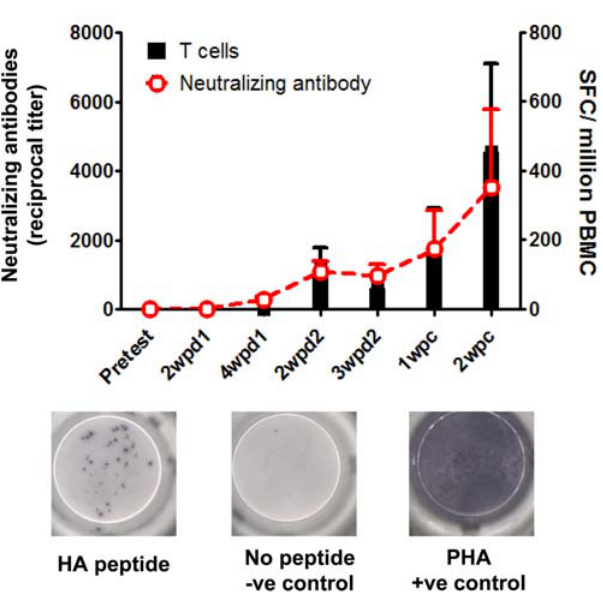
Figure 3. T cell responses against HA antigens in rhesus macaques and its relationship to the neutralizing antibody. T cell responses in the PBMC samples were measured by overlapping peptides and ex-vivo IFN- c ELISPOT assay. Data shown are the mean numbers 6 s.d. of spot-forming cells (SFC) per 10 6 PBMCs to HA peptide pools in the vaccinated animals at different time points after vaccination and challenge. Neutralizing antibody in the serum samples was measured by the microneutralization method using AH/05 virus isolate, data shown are mean titers 6 s.d. The T cell response and the neutralizing antibody were not detected in the control monkeys at all time points tested (data not shown).